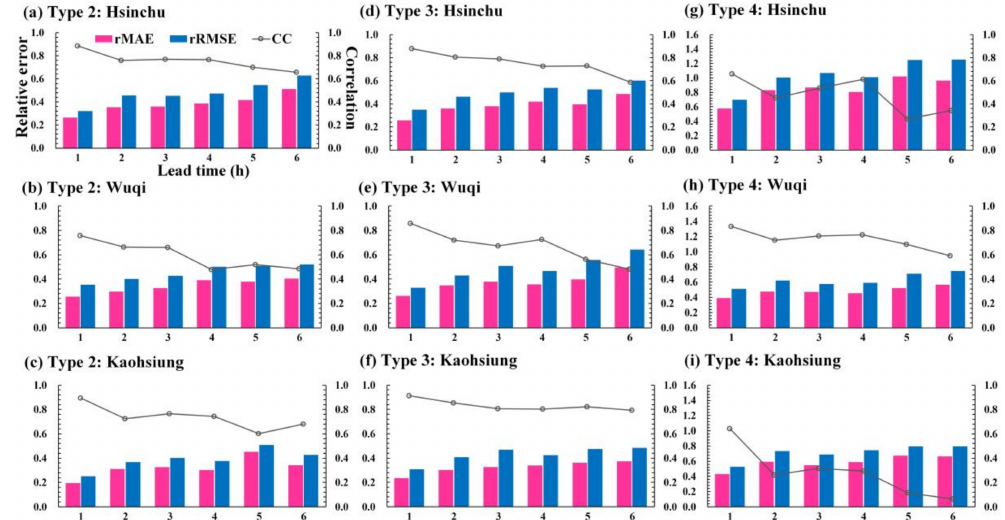
Figure 13. Performance of relative errors for typhoon track Types 2 ( a – c ), 3 ( d – f ), and 4 ( g – i ).